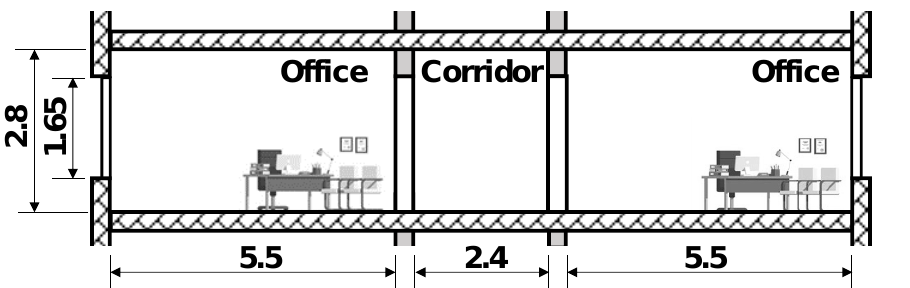
Figure 1. Longitudinal section of the model (roomwidth = 3.8 m) with dimensions in meters (scenario 1).